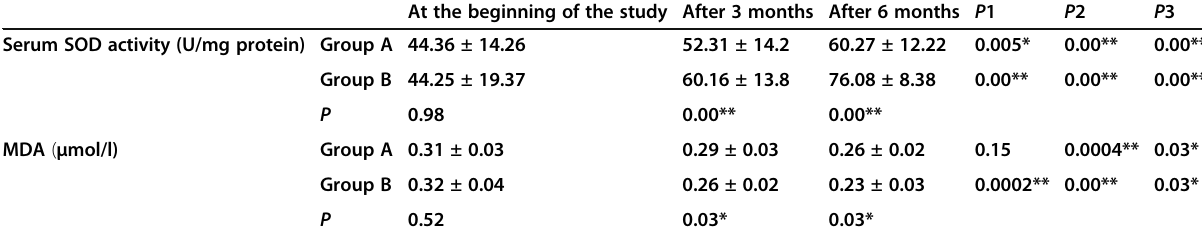
Table 5 Comparison of the serum SOD activity and MDA between the two studied groups At the beginning of the study After 3 months After 6 months P 1 P 2 Serum SOD activity (U/mg protein) Group A 44.36 ±